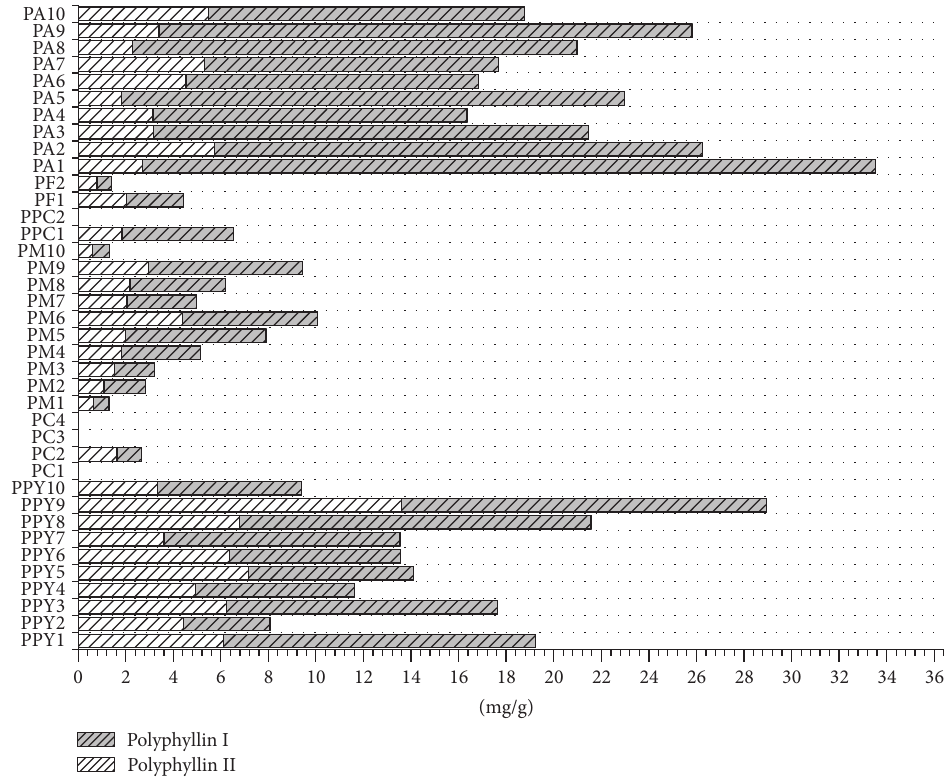
Figure 3: Content of polyphyllin I and polyphyllin II for six species of Paris